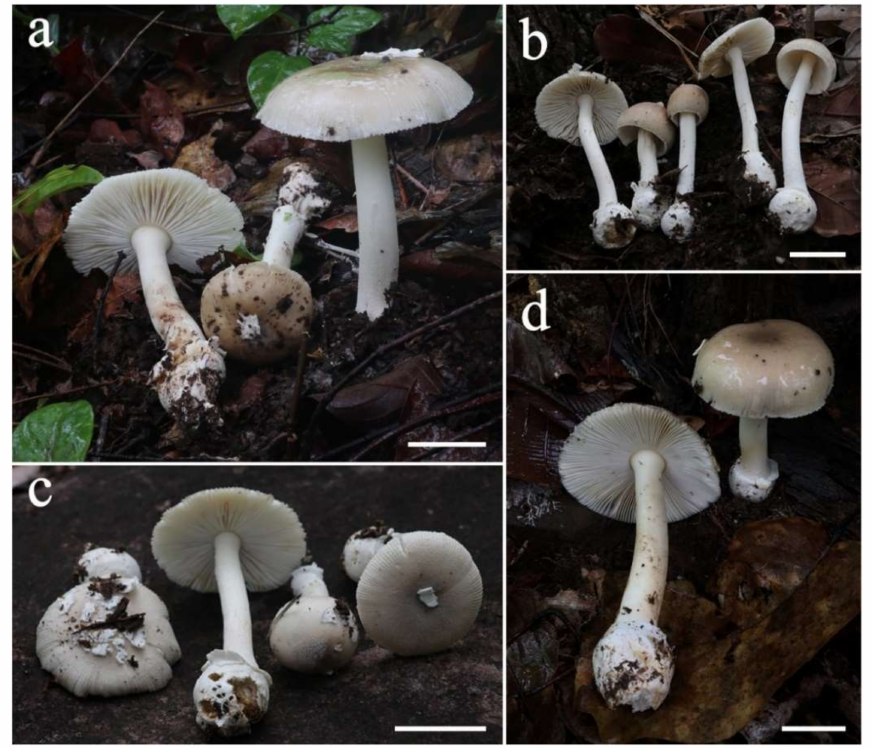
Figure 4. Different collections of Amanita ravicrocina shown in the field. ( a ) CMUB-39967 (holotype). ( b ) SDBR-STO-2020-235. ( c ) SDBR-STO-2020-229. ( d ) SDBR-STO-2020-283. Scale bars: ( a – d ) 3 cm. Description : Basidioma small to medium-sized. Pileus 3.0–8.5 cm diam., convex to plano-convex, often slightly depressed at center, brown (5E5), greyish orange (5B4–5) to orange white (5A2), often darker at center and becoming paler towards margin;